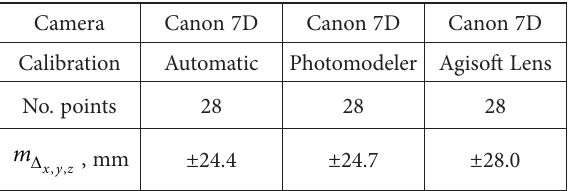
Table 5. Comparison differences for 3D models based on